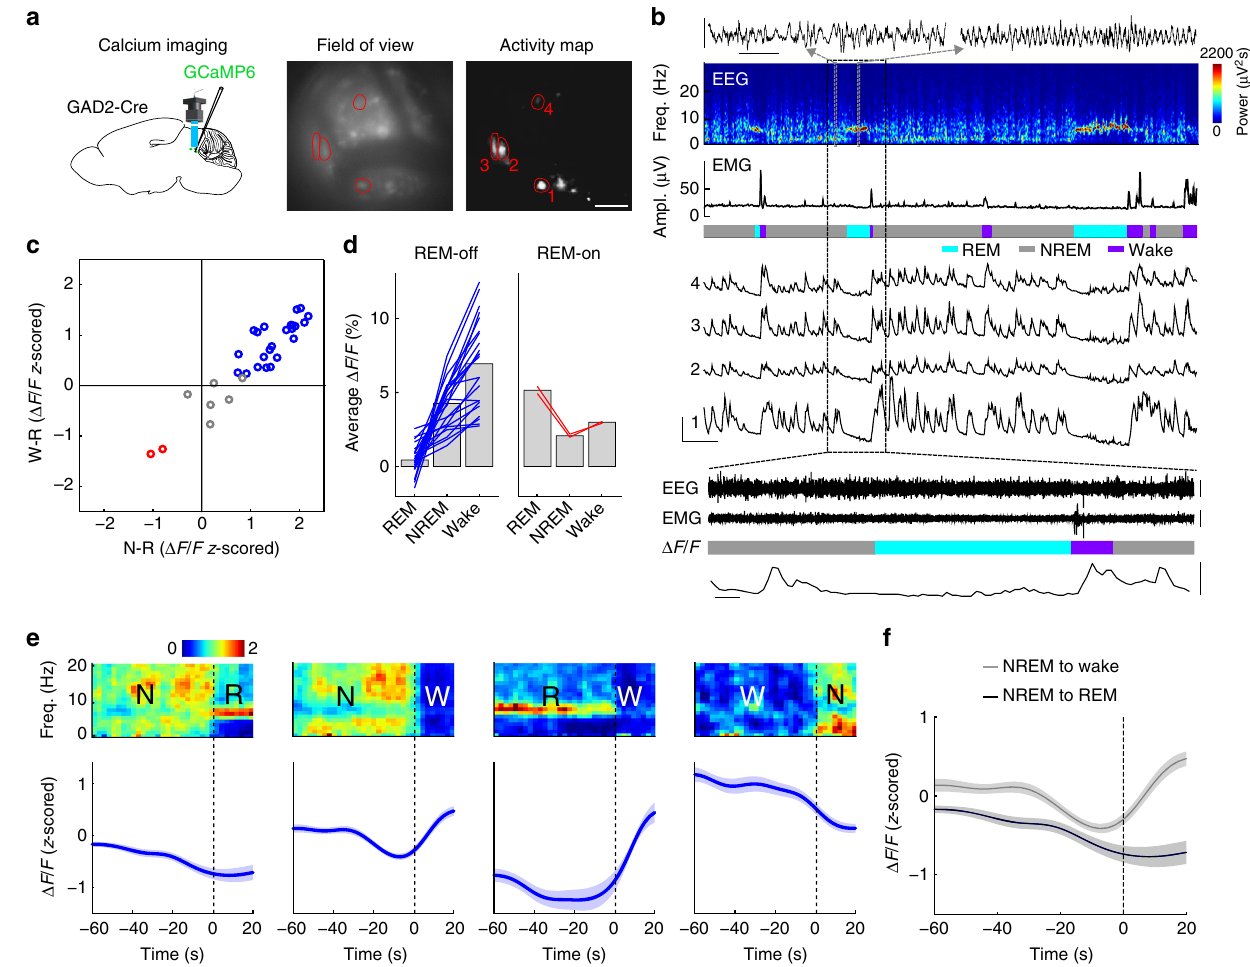
Fig. 4 Sleep – wake activity of vlPAG GABAergic neurons measured with calcium imaging. a Left, schematic of calcium imaging through GRIN lens. Middle, fi eld of view of an example imaging session. Right, pixel-wise activity map of an example imaging session. Red line, four example ROIs. Scale bar, 100 µ m. Brain fi gure adapted from Allen Mouse Brain Atlas (© 2015 Allen Institute for Brain Science. Allen Brain Atlas API. Available from: http://brain-map.org/ api/index.html). b EEG power spectrogram, EMG trace, color-coded brain state, and Δ F / F traces of the ROIs outlined in a (scale bars, 120 s, 20 % Δ F / F